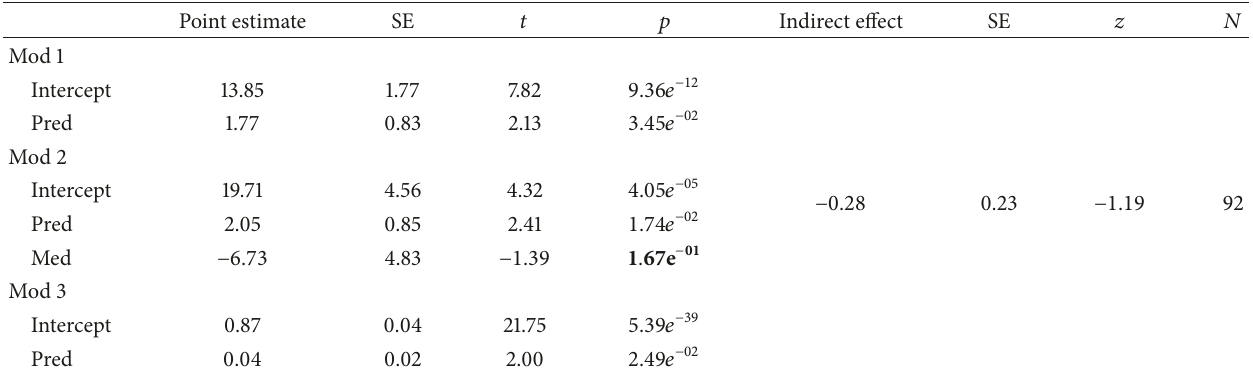
Table 6: Mediation analysis of the directionless similarity as mediator of the relationship between simplicity of information structure and the task completion